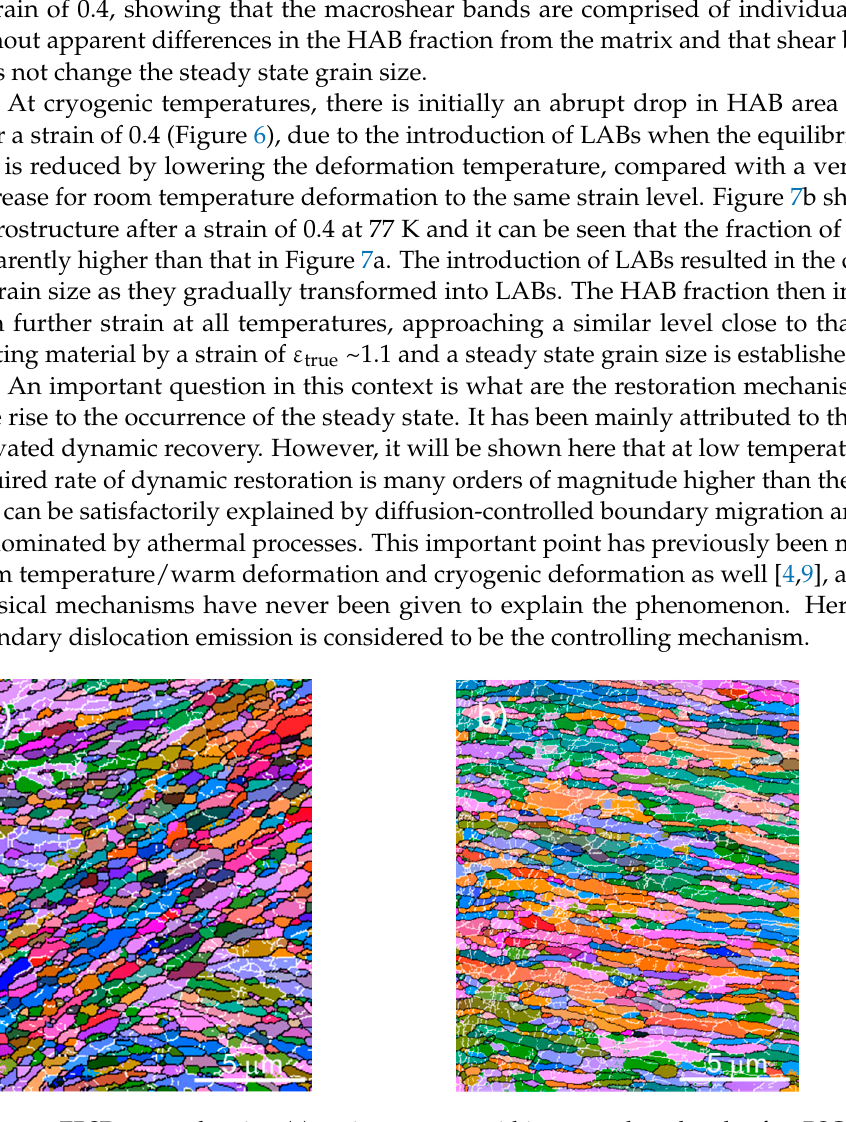
Figure 7. EBSD maps showing ( a ) grain structure within macroshear bands after PSC at room temperature to a strain of 1.1 and ( b ) the relatively high fraction of LABs in the early stages of PSC deformation at 77 K to a strain of 0.4.